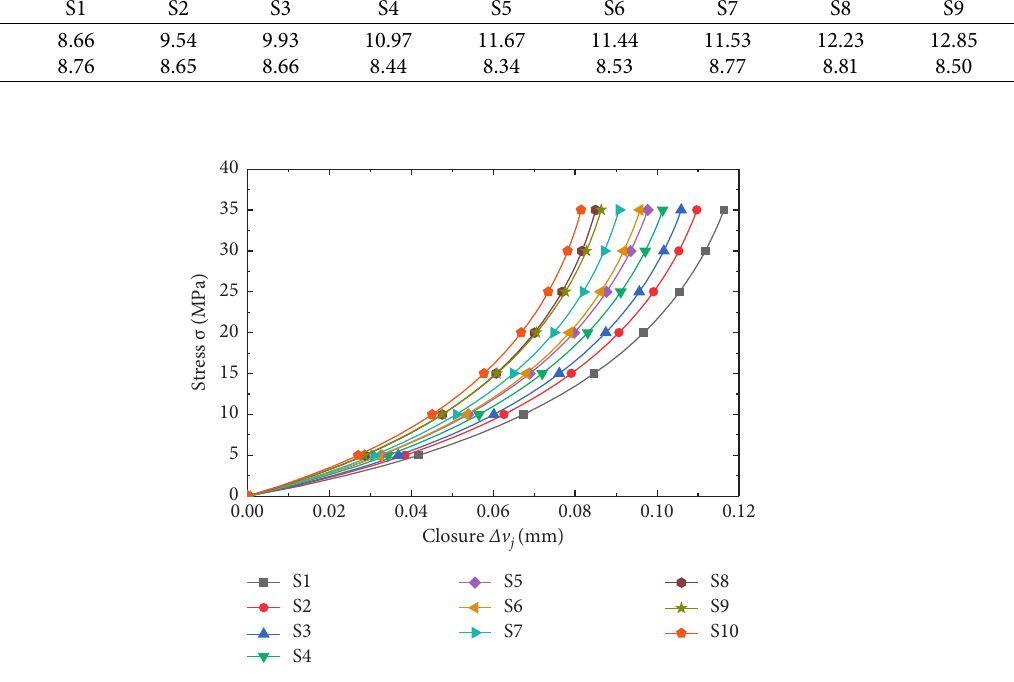
Figure 10: The stress-closure curves for joints of specimens